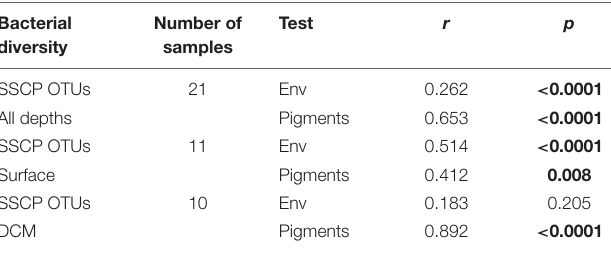
Values in bold are significant at p < 0.005 (probability based on 999 permutations).